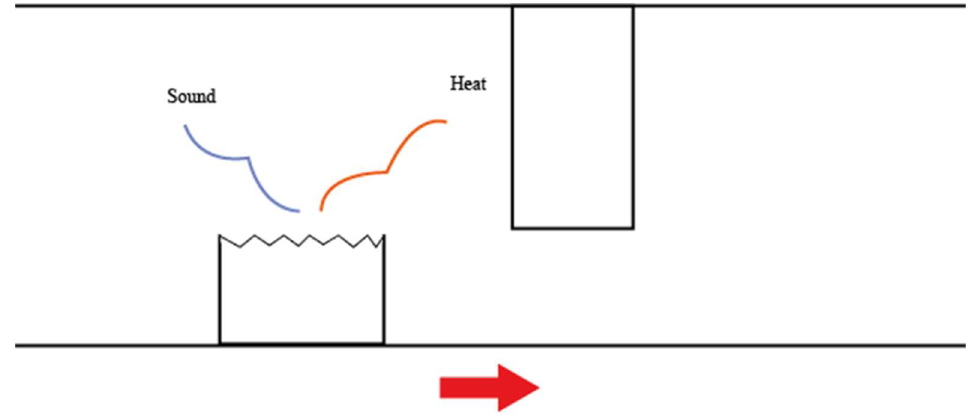
Figure 5. Sound and heat are released as the asperity breaks.